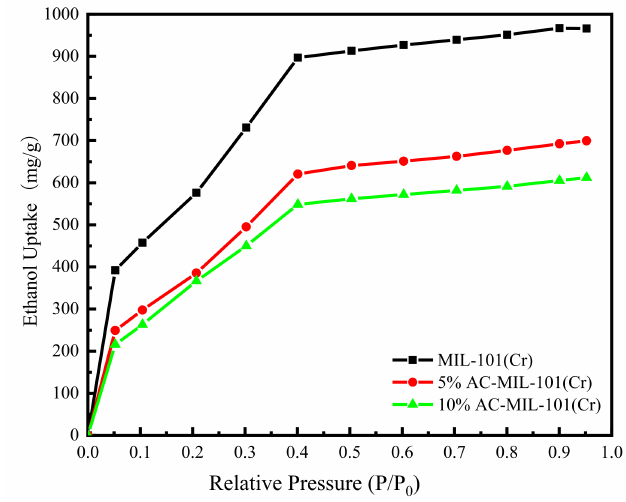
Figure 7. Ethanol vapor adsorption isotherms of MIL-101(Cr) and AC-MIL-101(Cr) at 303